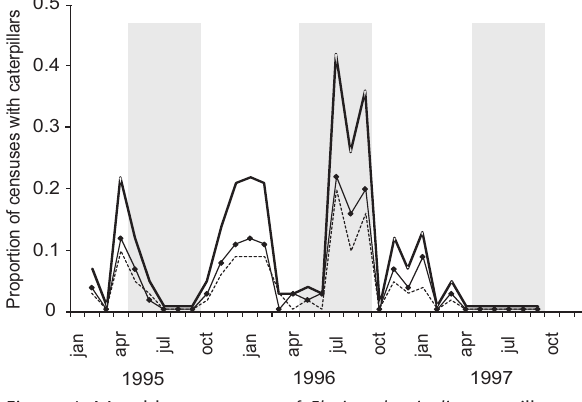
two species of Erythroxylum in the cerrado at Fazenda Água Limpa, Distrito Federal, Brazil. The gray bar indicates the dry season (May- September) in the region, black full line = proportion of caterpil- lars on the two species of hostplants, dotted line = proportion of caterpillars on E. suberosum , and gray full line = proportion of cat- erpillars on E. tortuosum .